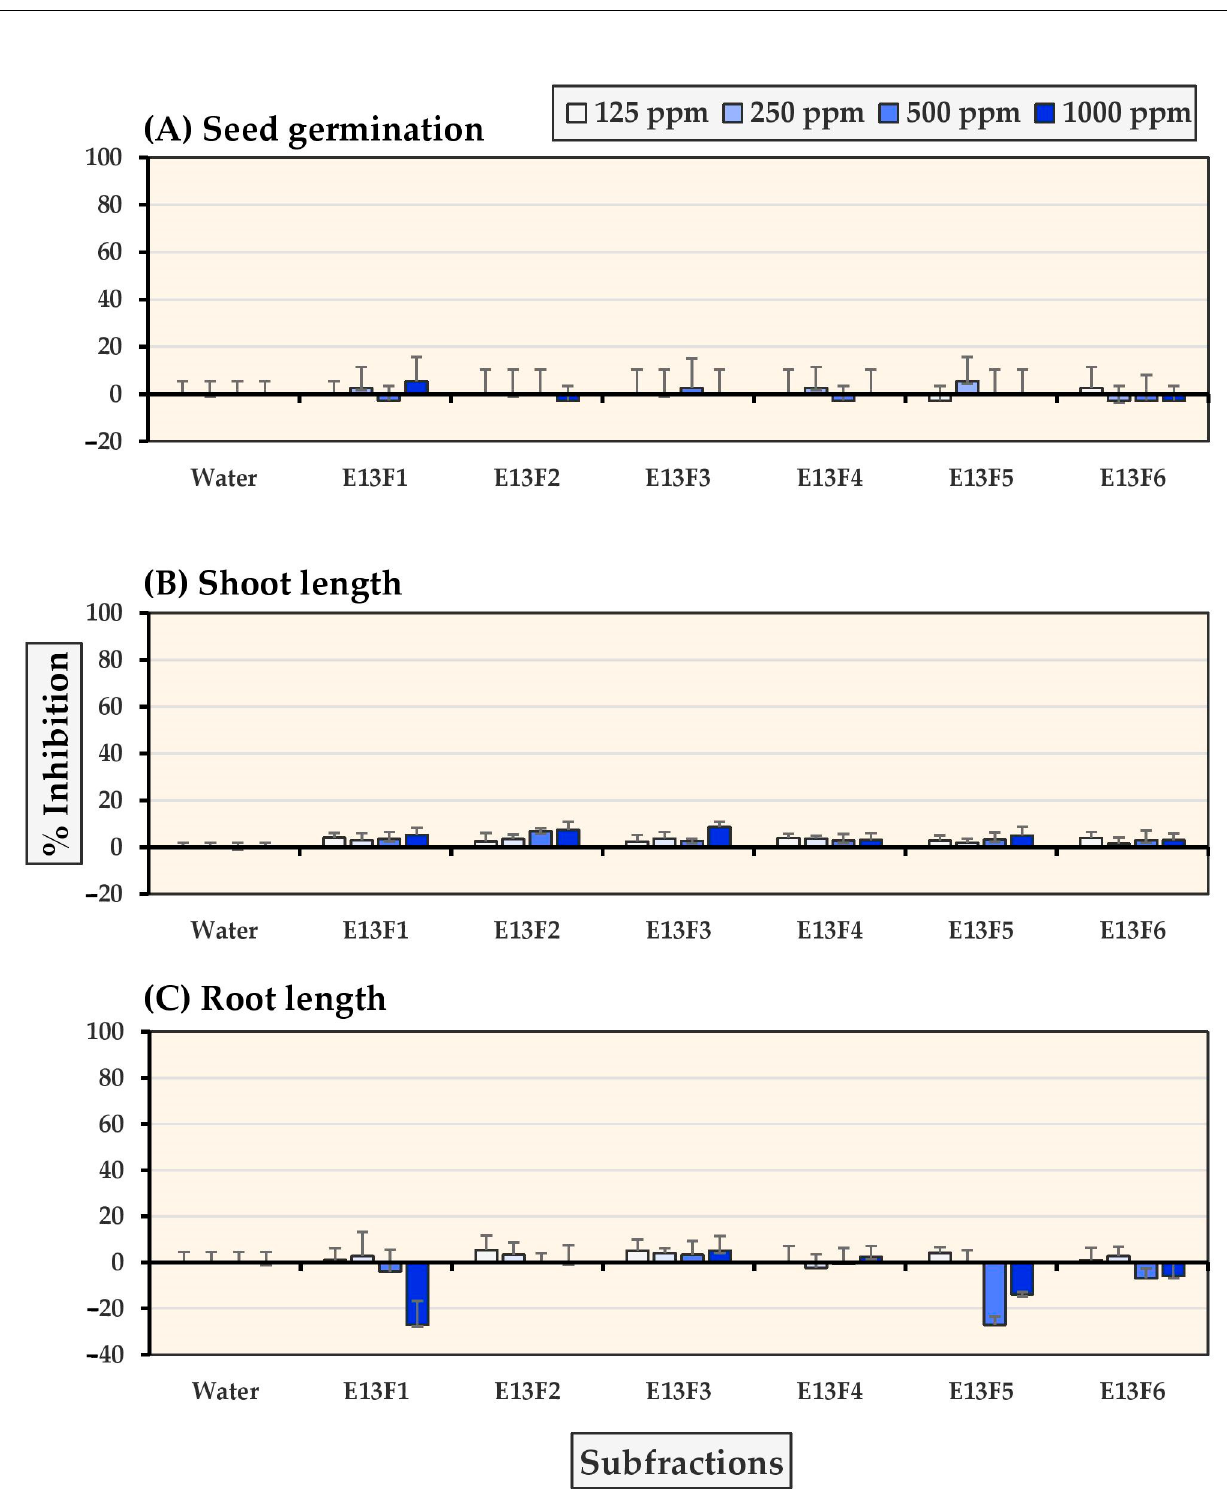
Figure 4. Inhibitory effects of S. platensis E13 subfractions on ( A ) seed germination, ( B ) shoot length, and ( C ) root length of barnyardgrass. Distilled water was used as a control.